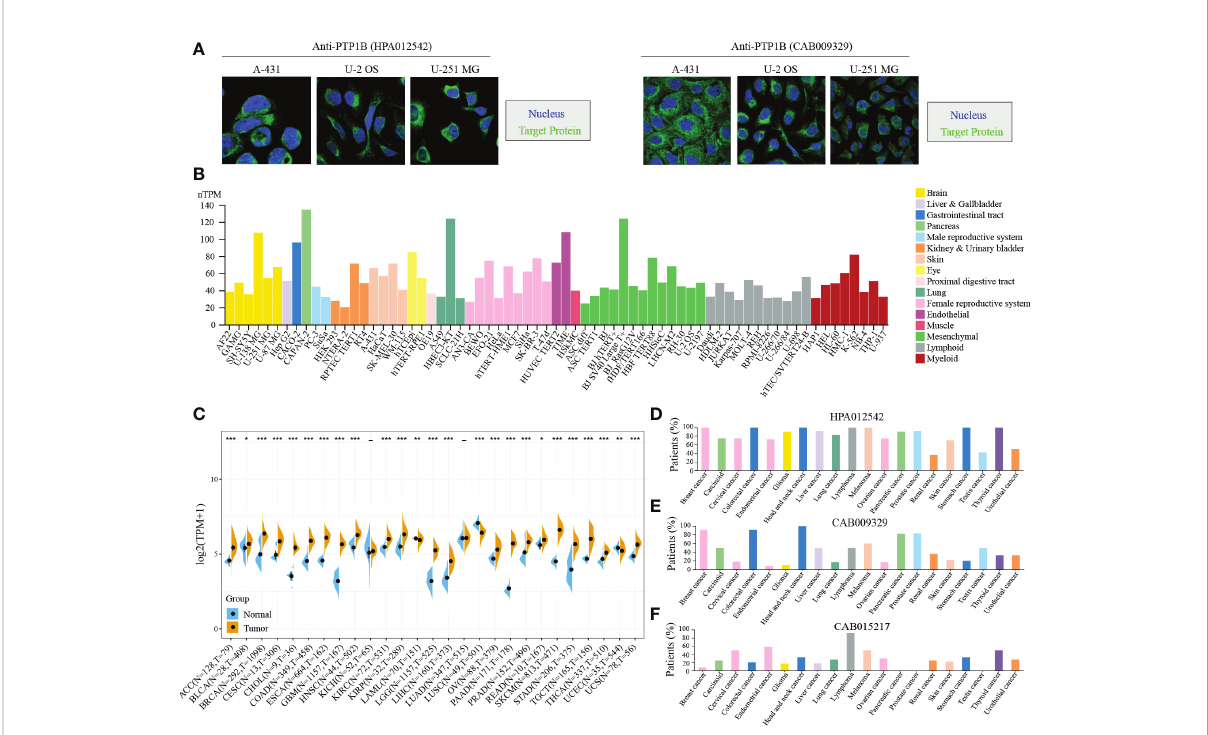
FIGURE 2 PTP1B in cancers. (A) PTP1B protein cellular localization in A-431, U-2 OS and U-251 MG cells by immuno fl uorescence. Blue presented nucleus; green suggested PTP1B. (B) PTP1B expression in cell lines of different cancer types from CCLE database. Different color corresponds to different tissues. (C-F) PTP1B expression in different types of cancers from TCGA and GETx database (C) , HPA012542 (D) , CAB009329 (E) and CAB015217 (F) . *p < 0.05; **p < 0.01; ***p <